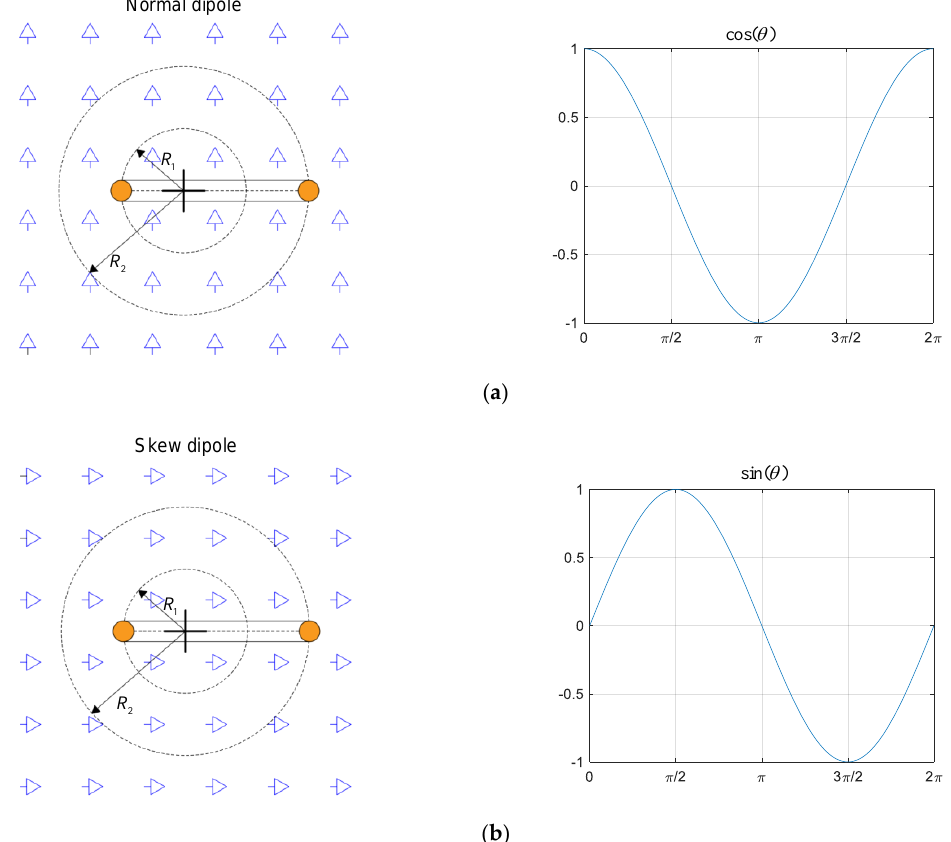
Figure 2. ( a ) Normal dipole signal; ( b ) skew dipole